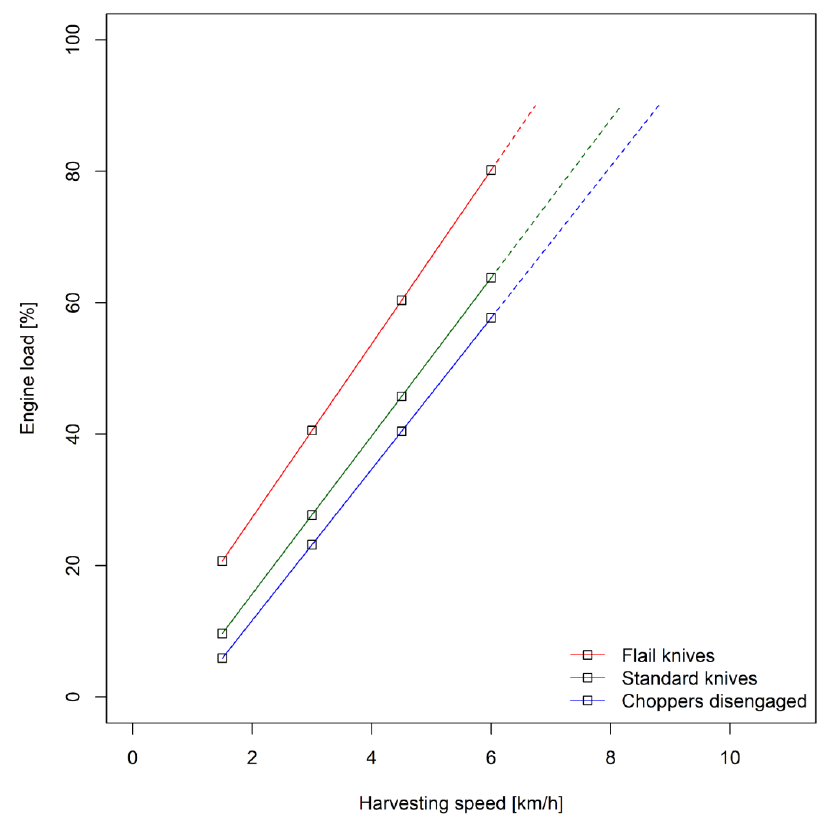
Figure 4. Percentage engine load of the combine harvester depending on harvesting speed for the levels of corn header configuration at cutting height level 1 (Markers indicate harvesting speed lev- els at cutting height level